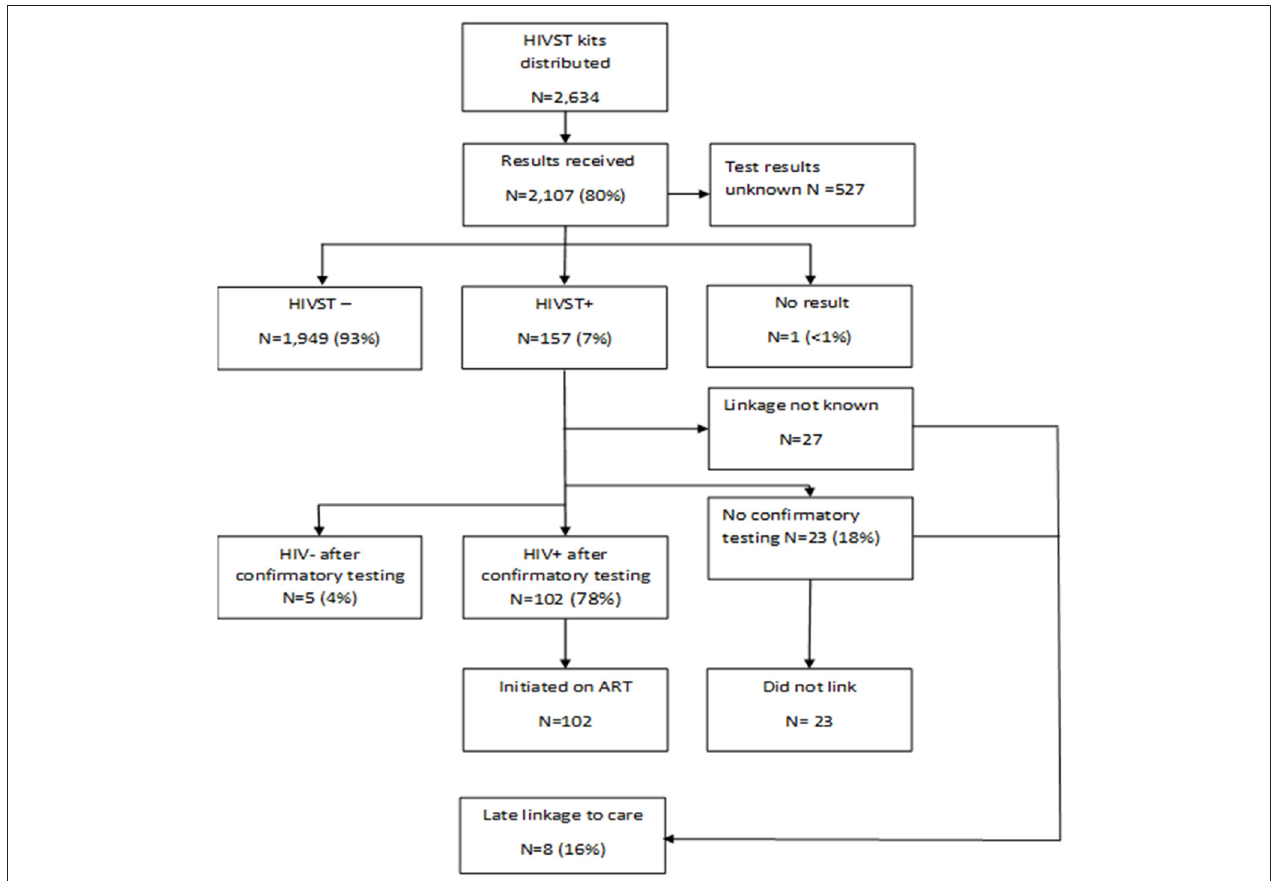
FIGURE 2 | HIVST testing, results and linkage to care flow chart. Percentages are relative to the pervious linked box(es).